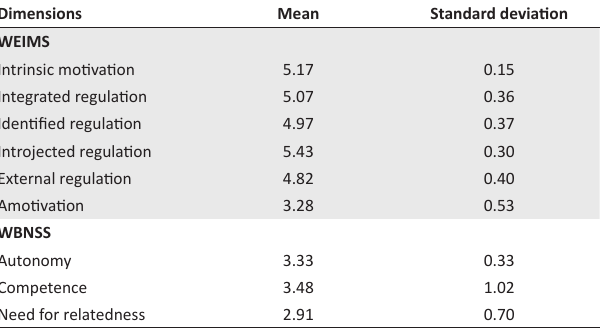
TABLE 1: Descriptive statistics for employee motivation as measured by the Work Extrinsic and Intrinsic Motivation Scale and Work-Related Basic Need Satisfaction